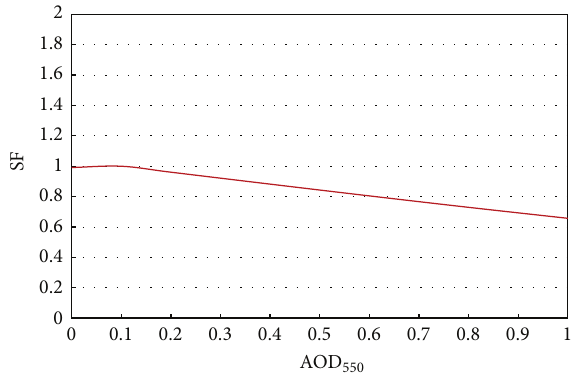
Figure 2: Spectral factor versus AOD 550 of a HCPV module made up of lattice-matched GaInP/GaInAs/Ge solar cells and poly(methylmethacrylate) (PMMA) Fresnel lenses [15].